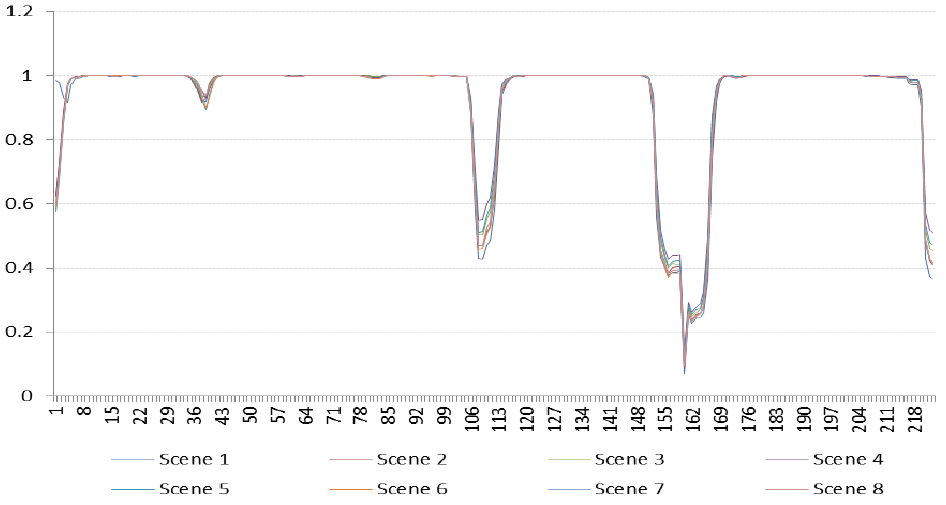
Figure 16. Correlation for continuous band for each scene of Low Altitude.